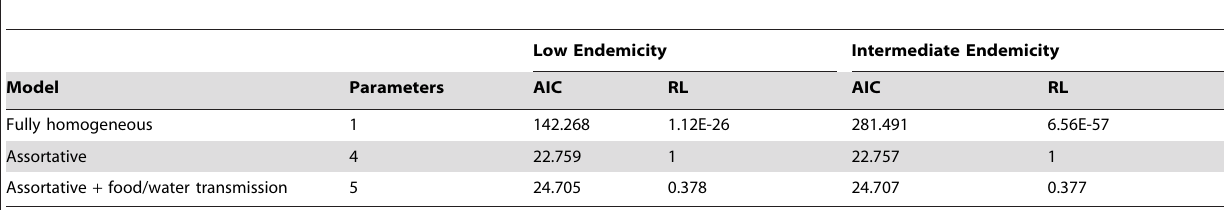
Table 2 . Comparison of three models of contact function (equations 4, 5 and 6) by the Akaike Information Criterion (AIC) and the relative likelihood (RL) of the